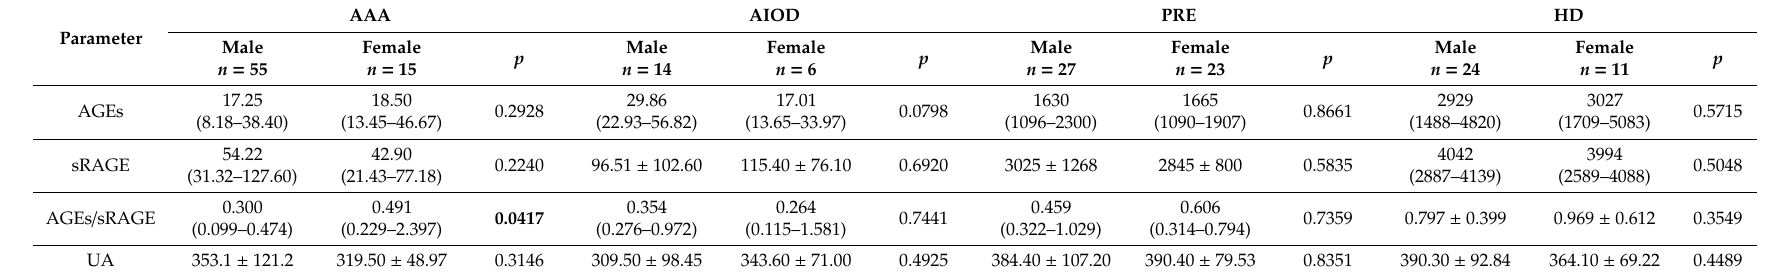
Table 3. The influence of gender on AGEs, RAGEs, AGEs / RAGEs ratio, and UA in the studied